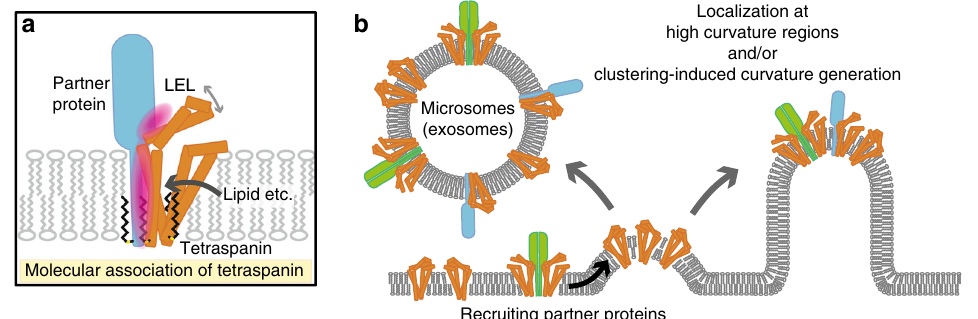
Fig. 6 Hypothetical model of the tetraspanin function. a The molecular association of tetraspanin and its partner proteins is mediated through both the TM and LEL regions, but its dependency is different among the partner proteins. Lipid binding to the central cavity could modulate the molecular association by affecting the LEL conformation. b The highly asymmetric shape of the tetraspanins suggests their localization at high curvature regions and/ or clustering-induced curvature generation. Partner proteins should also be recruited and sorted to the respective regions, such as the microvilli tips and microsomes